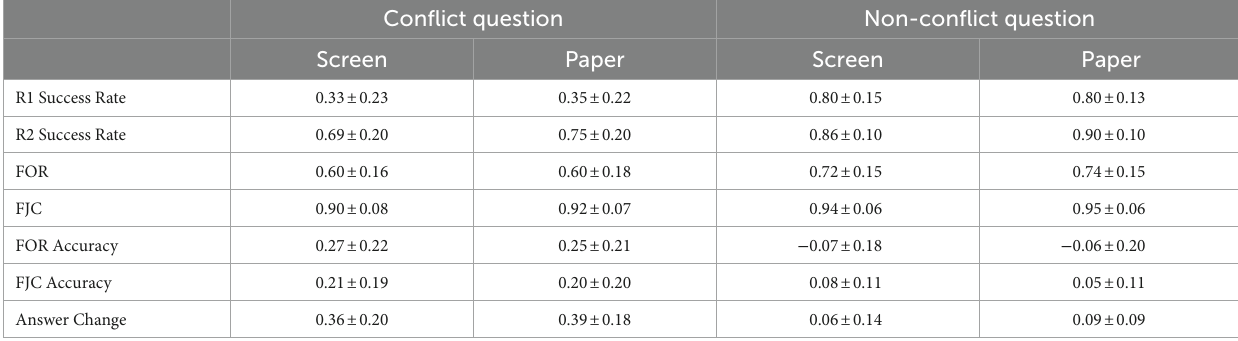
TABLE 2 Descriptive statistics ( M ± SD ) in Experiment